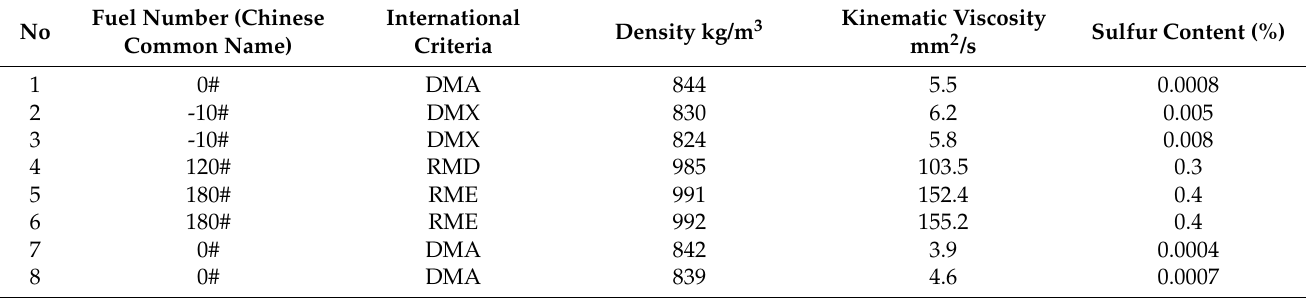
Table 1. Detailed information on the collected marine fuel oils. Note that all the fuels were used for the main